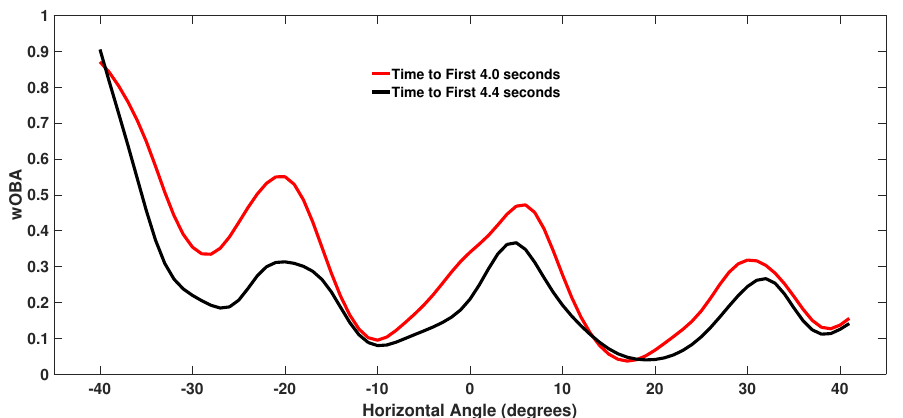
Figure 8. Weighted on base average (wOBA) for left-handed batter (LHB) batted balls with a speed s of 97 miles per hour and a vertical angle v of − 12 ◦ for two time to first ( r ) values. Figure 7 plots wOBA ( b ) for right-handed batters for two different values of r as a function of the horizontal spray angle h with the initial batted ball speed and vertical launch angle fixed at s = 87 mph and v = − 9 ◦ . The red curve corresponds to a faster than average time of r = 4.0 seconds and the black curve corresponds a slower than average time of r = 4.4 seconds. The four minima in the curves correspond to the typical position of the four infielders against right-handed batters. Near these minima we have a ground ball hit directly at an infielder and the wOBA values are similar for the different values of r